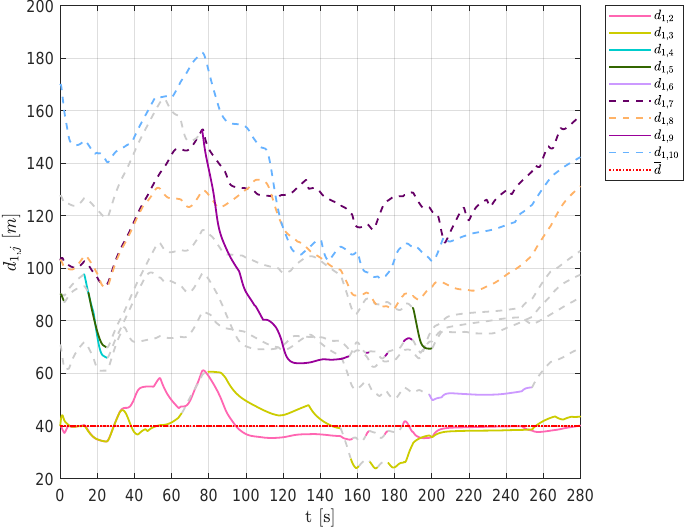
Figure 27. Scenario #3—10 aircraft: distances between UAV 1 and the other swarm vehicles. Solid lines are used for visible aircraft and dashed gray lines are employed whenever they are no longer visible, whereas dashed colored lines are used for never visible UAVs. The desired distance is highlighted using a dotted red